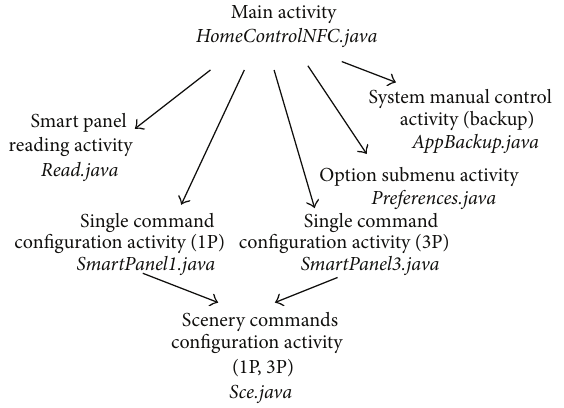
Figure 4: Logic architecture of the NFC-Home Control software application: relationships among activities